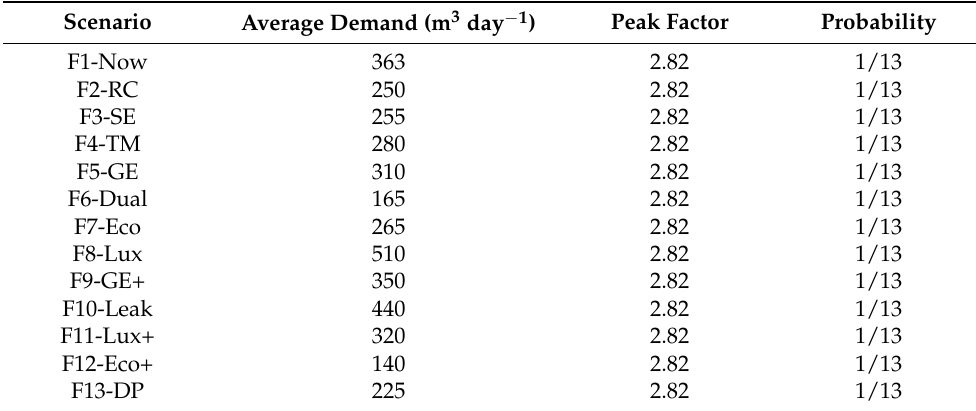
Table 5. Average water demand for city S for different future scenarios [6], and assumed values for the peak factor and scenario